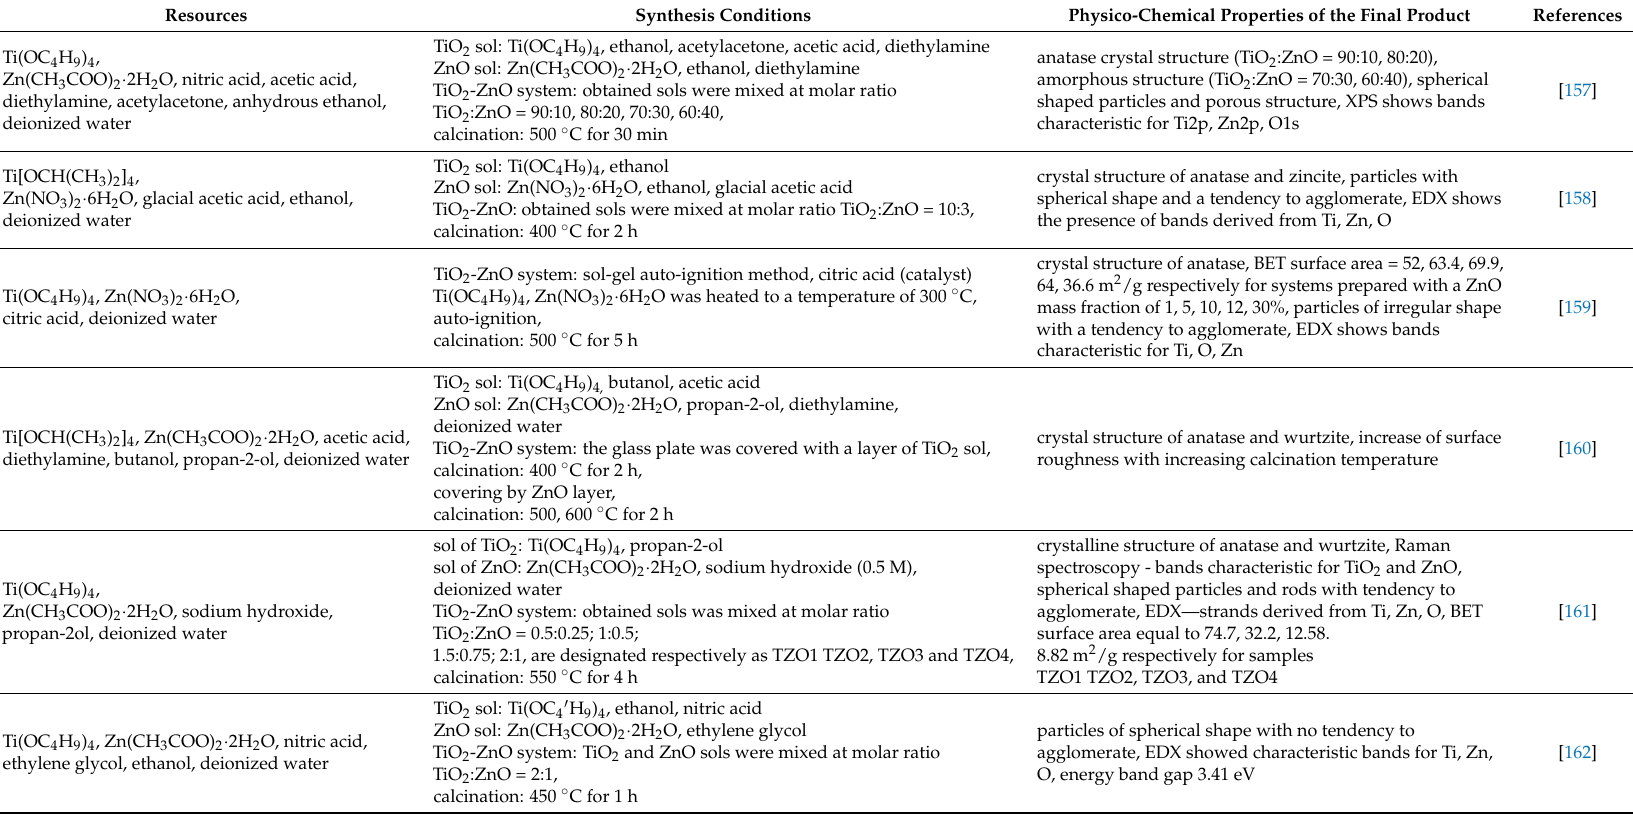
anatase crystal structure (TiO 2 :ZnO = 90:10, 80:20), amorphous structure (TiO 2 :ZnO = 70:30, 60:40), spherical shaped particles and porous structure, XPS shows bands characteristic for Ti2p, Zn2p, O1s